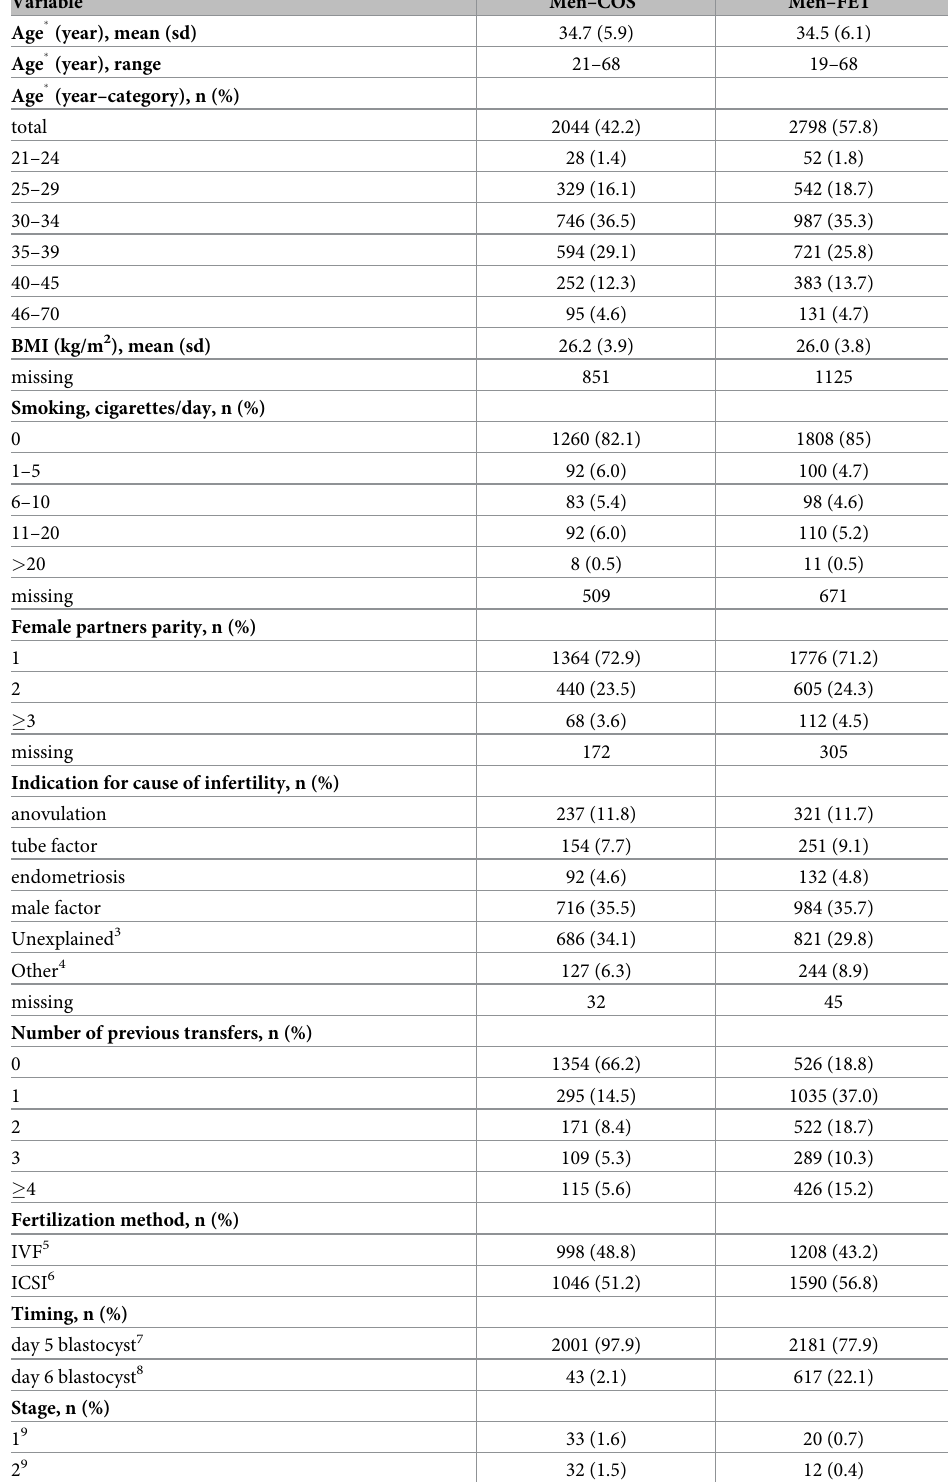
Table 1. Men, treatment, blastocyst timing, morphology and implantation